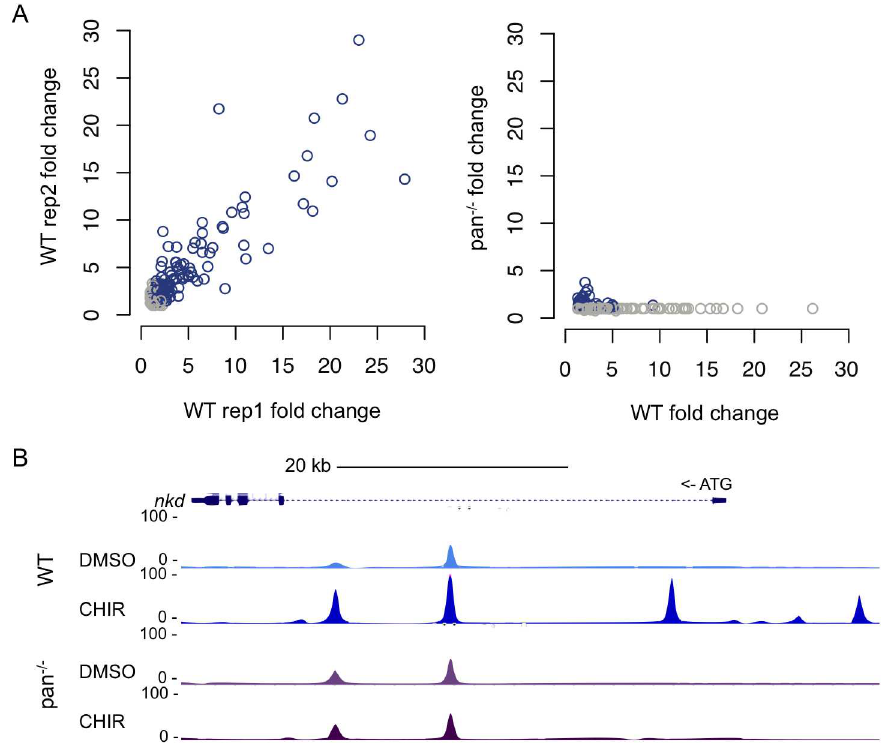
Fig 7. Wnt/Wg-induced enhancers depend on Pan. (A) Scatterplots show signal fold induction at induced enhancers for STARR-seq replicates in wild-type (WT) cells (left) and for comparison of WT versus pan -/–AF1AD26 (pan -/- ) cells (right). Grey dots indicate non-significant induction (p-value > 0.001). (B) UCSC browser screenshot of STARR-seq tracks in WT and pan -/--AF1AD26 (pan -/- ) cells for nkd gene locus.